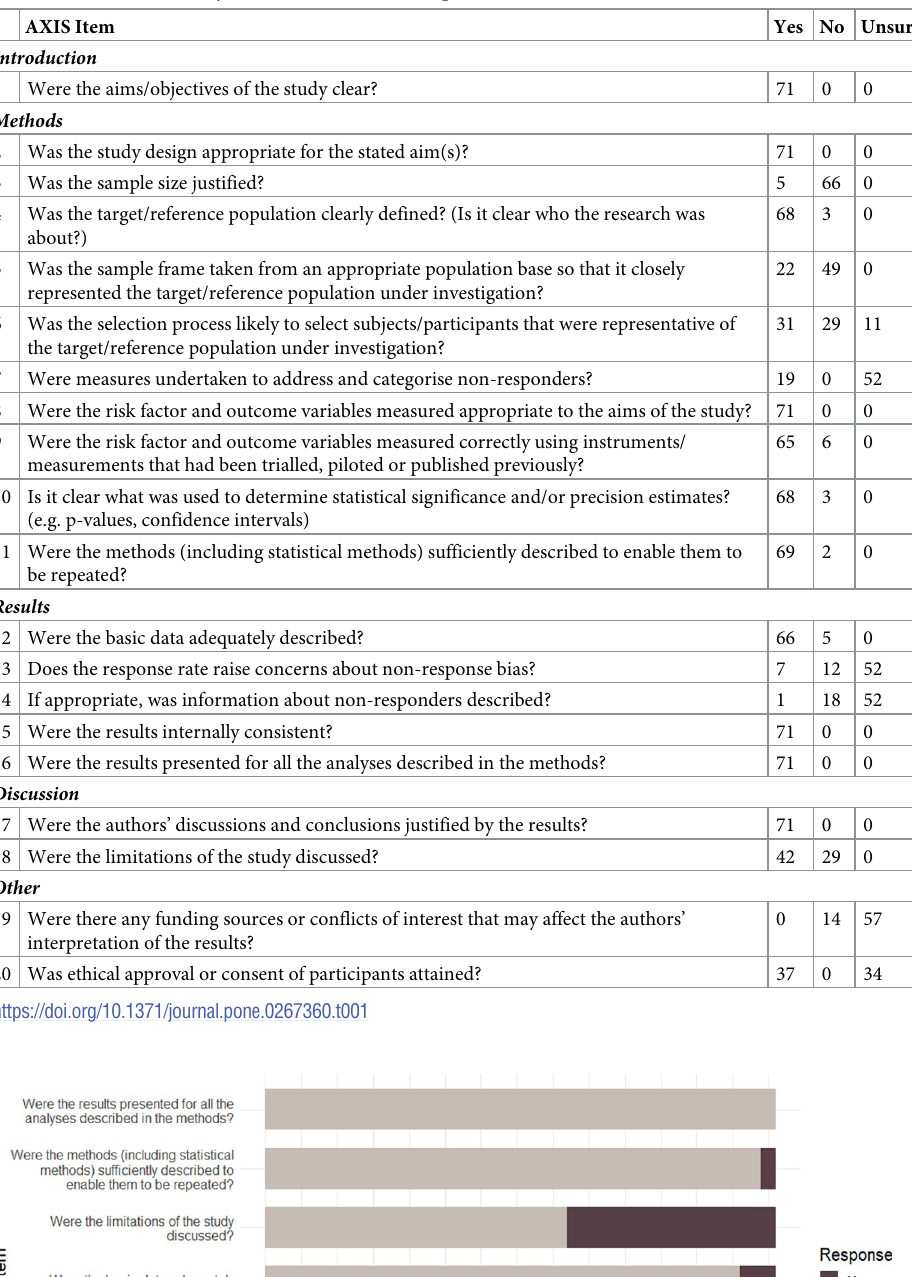
Table 1. Total number of “yes”, “no” and “unsure” responses for each AXIS item.